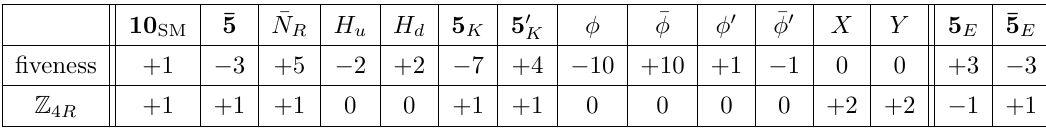
Table 1 . The charge assignment of the (cid:12)veness symmetry and the gauged Z 4 R symmetry. Here, we (cid:12)x the Z 4 R charges of the Higgs doublets to 0 which is motivated by pure gravity mediation model [46{48]. An extra multiplet ( 5 E ; (cid:22)5 E ) is introduced to cancel the Z 4 R {SU(5) 2 anomaly